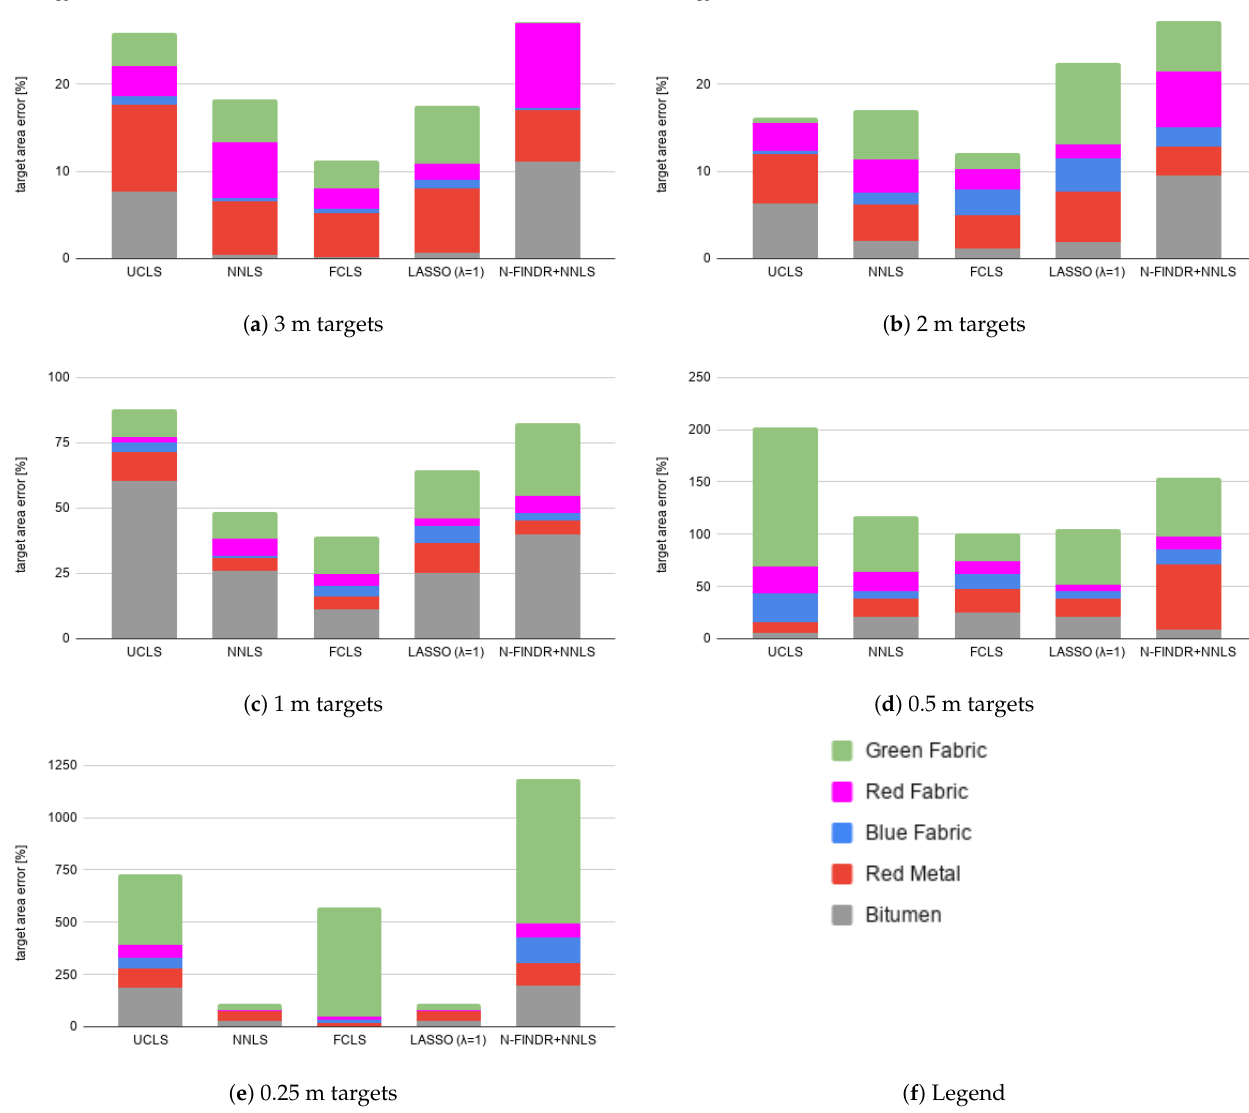
Figure 16. Target area error from abundance estimation for the DLR HySU benchmark. The unsigned relative error ˆ A t − A t | / A t displayed here for each algorithm, target size and target material was obtained by combining the estimated | areas from Table 2 and the actual measured areas from Table